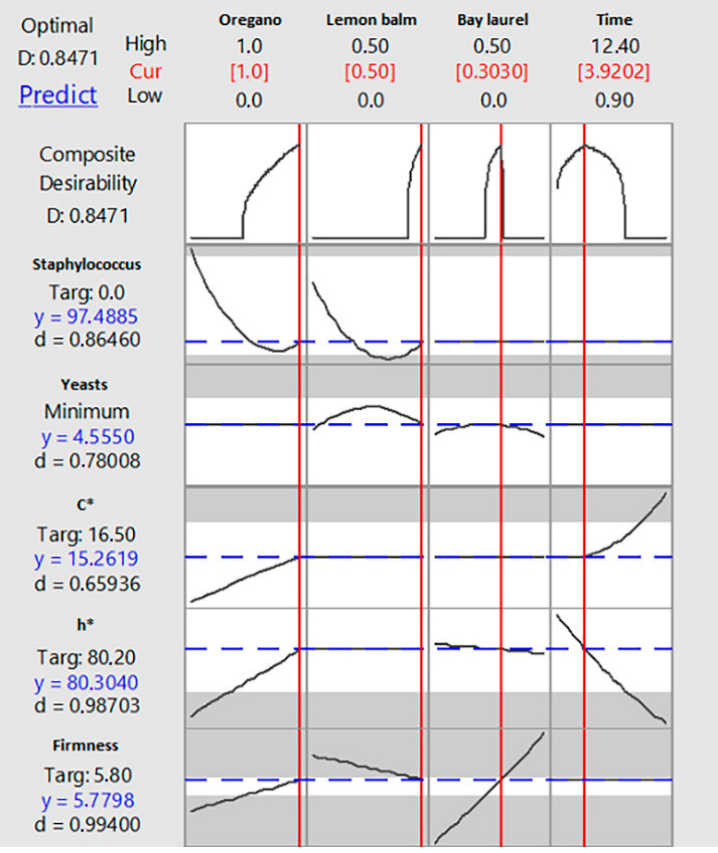
Figure 6. Multiply response optimization plot for growth of Staphylococcus (Y S ) and yeasts (Y Y ), C* (Y C* ), h* (Y h* ) and firmness (Y F ).